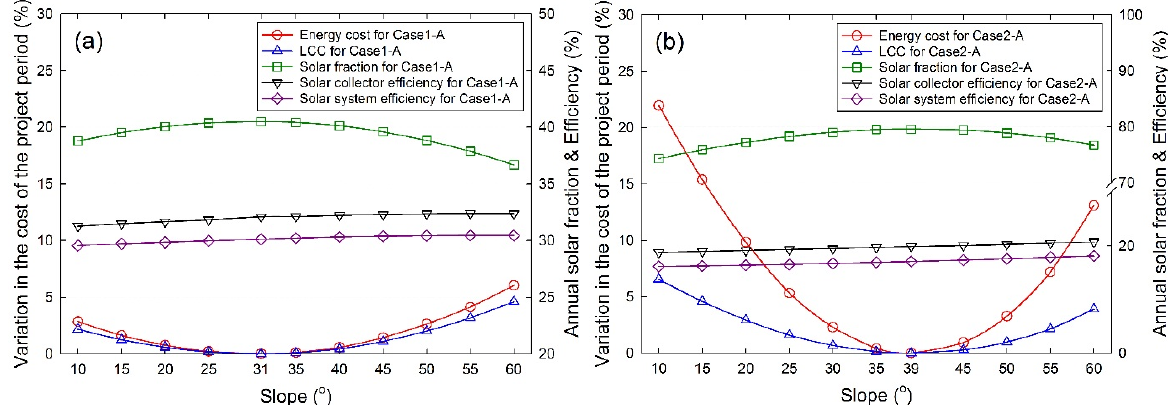
Figure 9. Effect of collector slope on the LCC, annual solar fraction, and efficiency of the optimal SWH systems: ( a ) Case1-A and ( b )